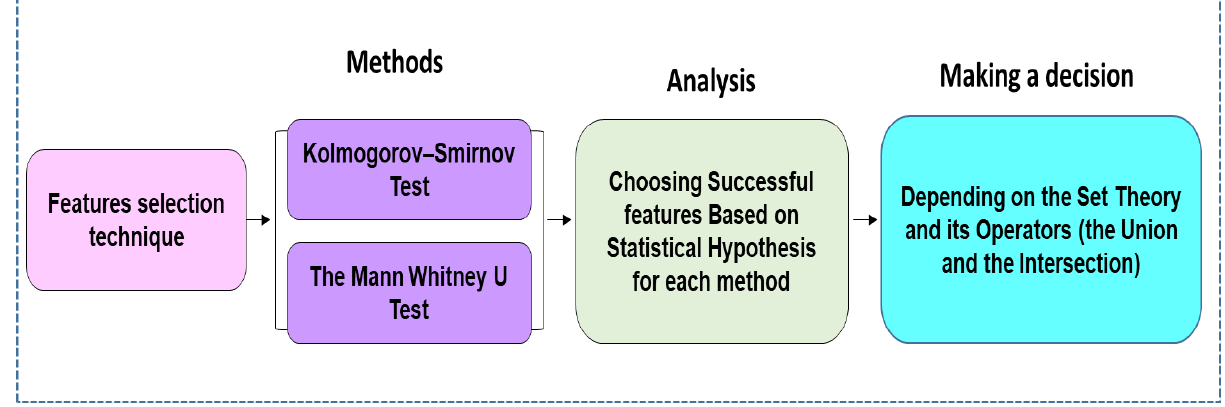
Figure 2. Two-stage feature selection method. Note: Stage 1 was obtained the by Kolmogorov–Simonov and Stage 2 by the Mann–Whitney U test. Table 2. Stage 1 of the features selection process using Kolmogorov–Smirnov metric.